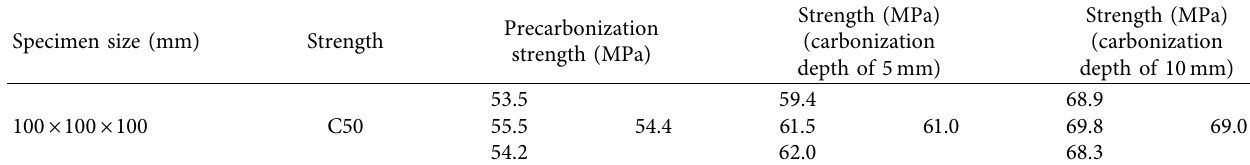
Table 5: Compressive strength of standard specimen under carbonization erosion.